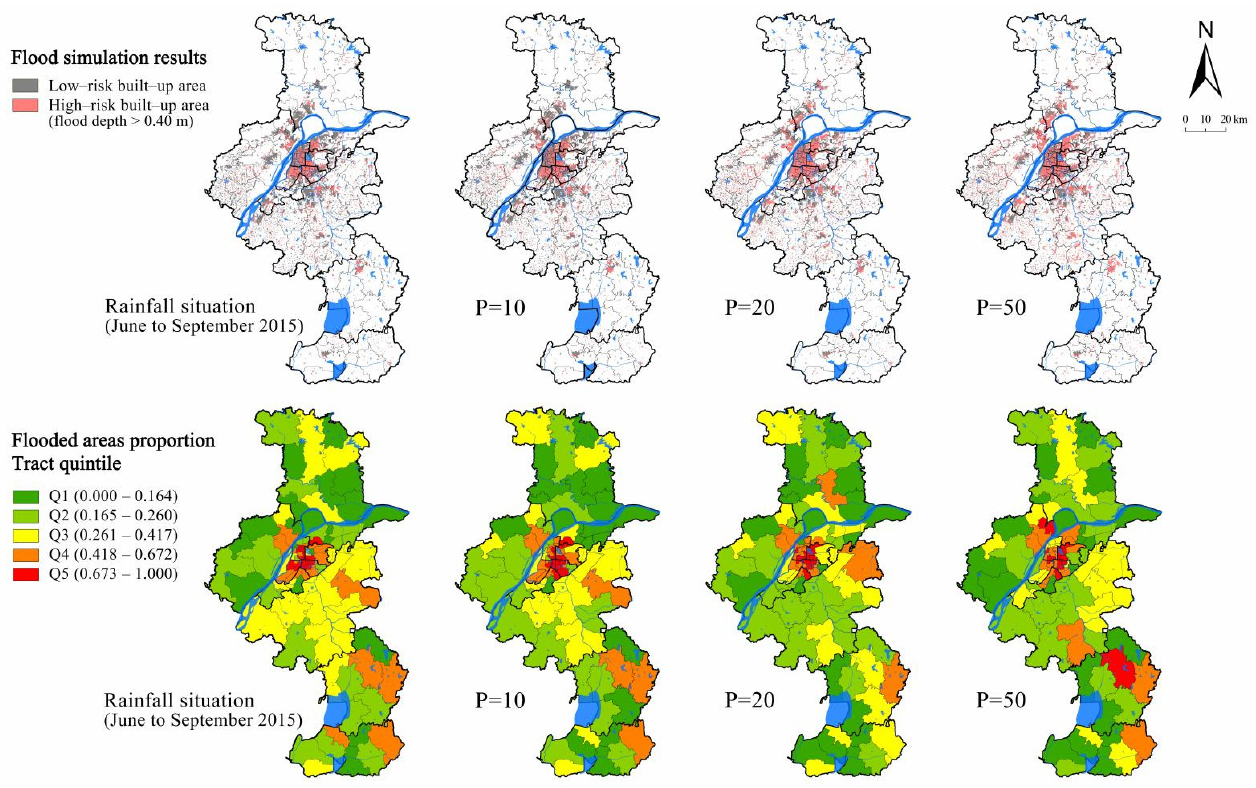
Figure 2. Proportion of flooded census-tract area of Nanjing, China.